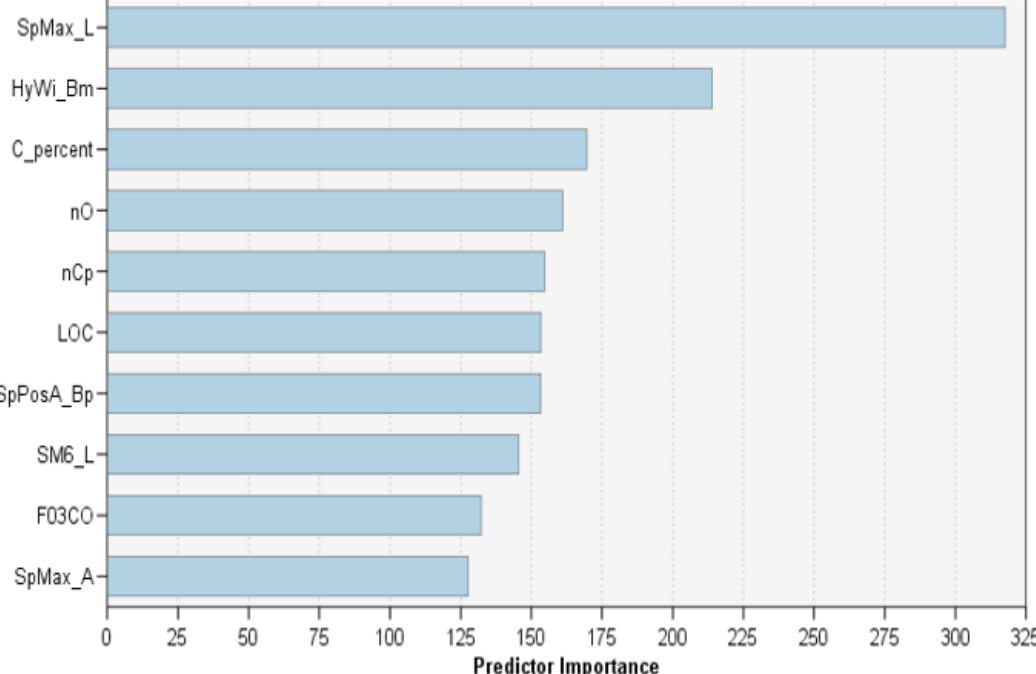
Figure 3. The ten most important predictive molecular descriptors according to the balanced RTs model. They are SpMax_L, HyWi_B(m), C%, nO, nCp, LOC, SpPosA_B(p), SM6_L, F03[C-O], and SpMax_A. Their definitions and DRAGON blocks are shown in Table 4. Table 4. The definition and DRAGON block of the top 10 molecular descriptors ranked according to their contribution to the balanced RTs classification process.